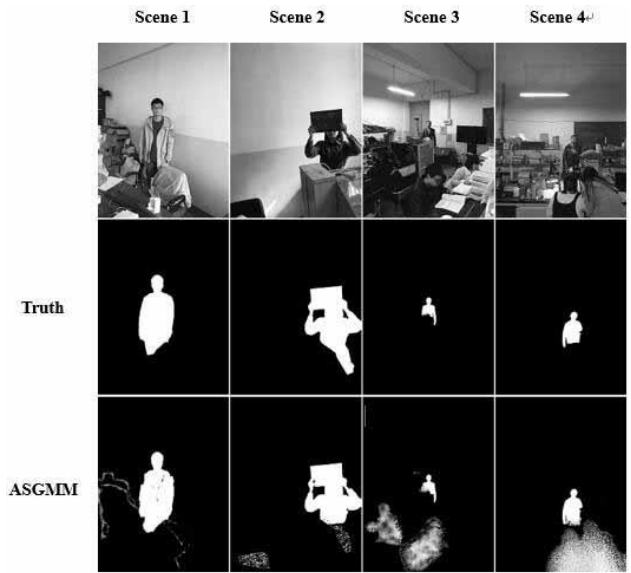
Figure 4. Detection result of